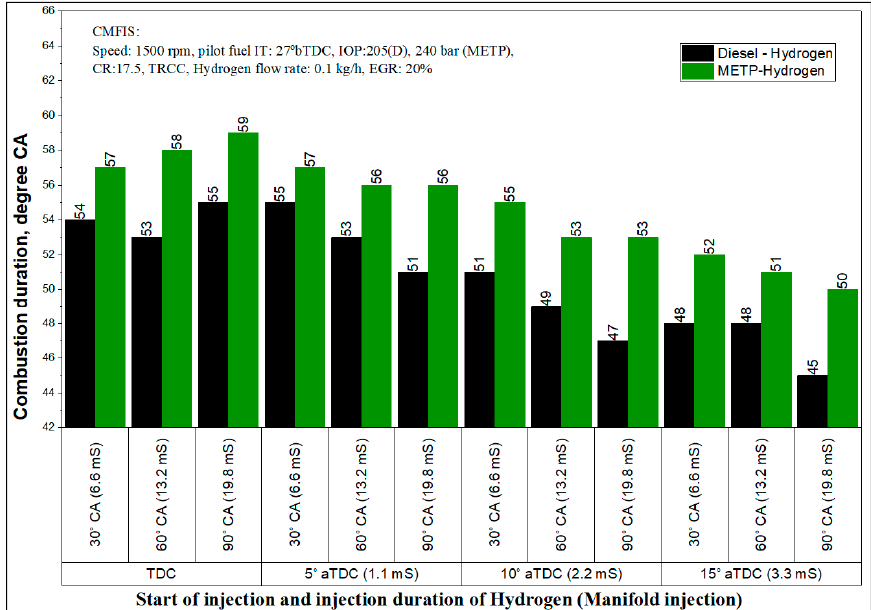
Figure 16. Combustion duration for manifold injection of hydrogen in CMFIS based dual-fuel engine.